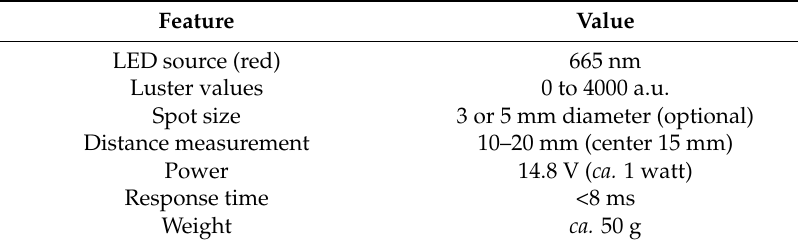
Table 2. Technical features of the new CZ 72H luster